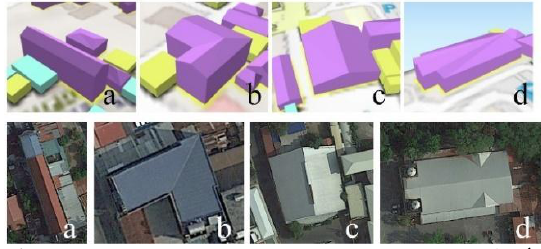
Figure 15. Sample 3D reconstructed building models for (a) Figure 11. Gable roof building’s OSM building footprints rectangular gable, (b) l-shaped gable, (c) irregular pentagon overlaid on the aspect and slope map (left) and aerial photo gable, (d) irregular gable. (right).